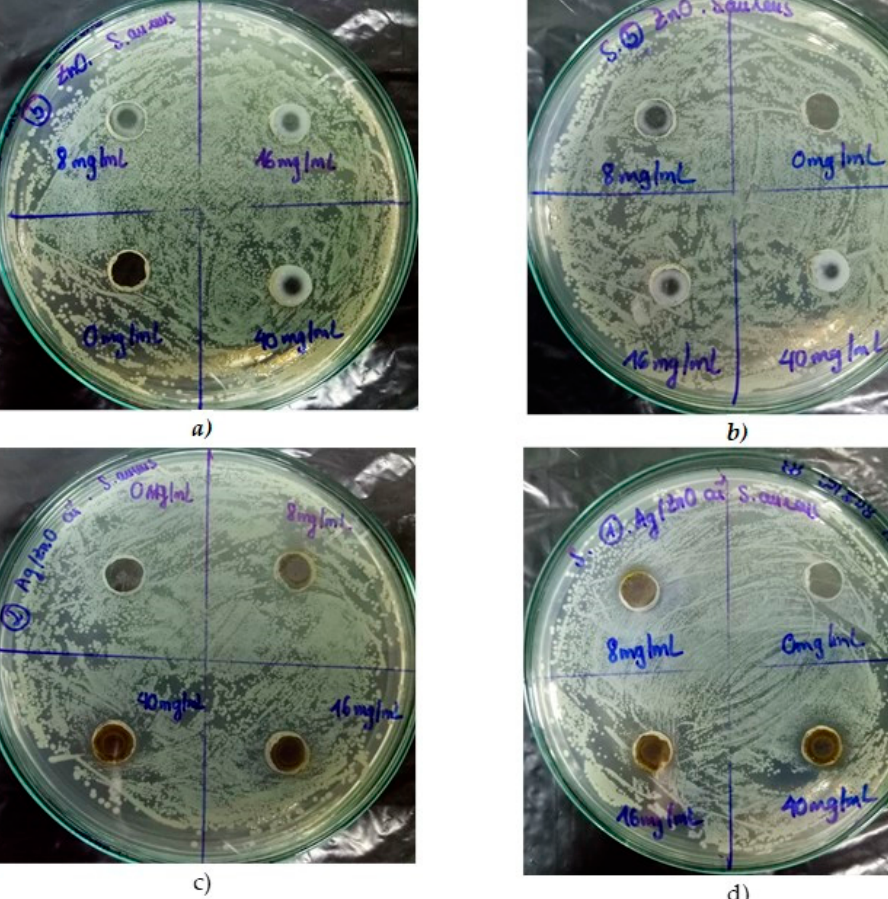
Figure 9. Photographs of antibacterial test against S. aureus bacteria (agar-well diffusion method) for pure ZnO nanoparticles (( a ): without light irradiation; ( b ): under light irradiation) and Ag-loaded ZnO nanoparticles (( c ): without light irradiation; ( d ): under light irradiation).